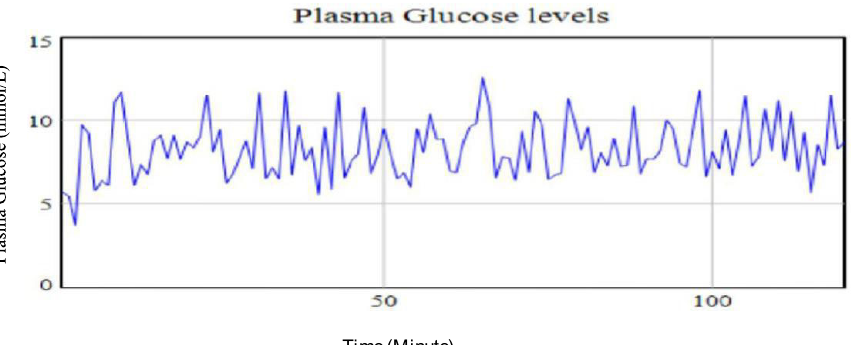
Figure 8. Plasma glucose levels using identified parameters for the extended Bergman Minimal Model for a type II diabetic patient with a 33.33% increase in amount of ingested carbohydrates. Case 2: Lowering the stress level while maintaining carbs and exercise intensity at base